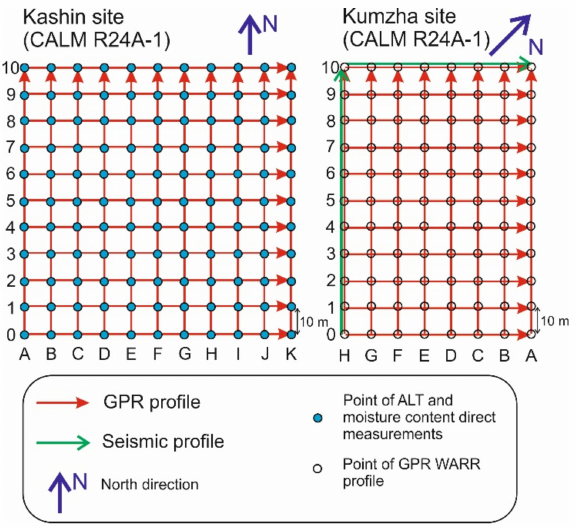
Figure 2. Sketch of the GPR and seismic transects and points of direct